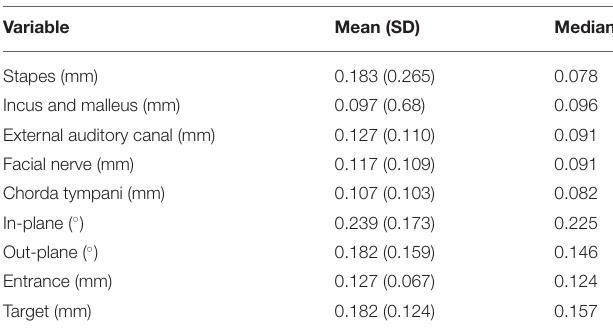
TABLE 2 | Intraoperative accuracy.